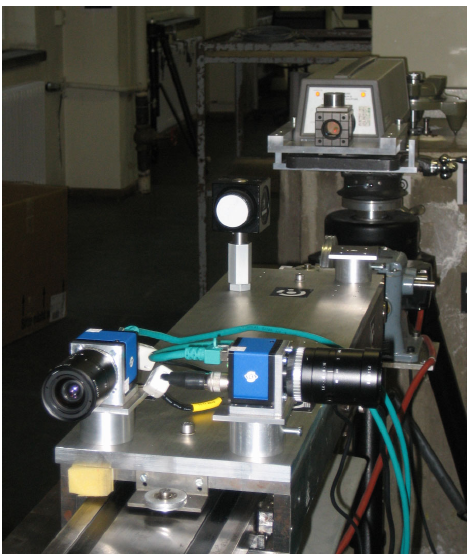
Figure 3. Cameras in orthogonal configuration on platform. The movement is measured by a laser interferometer.